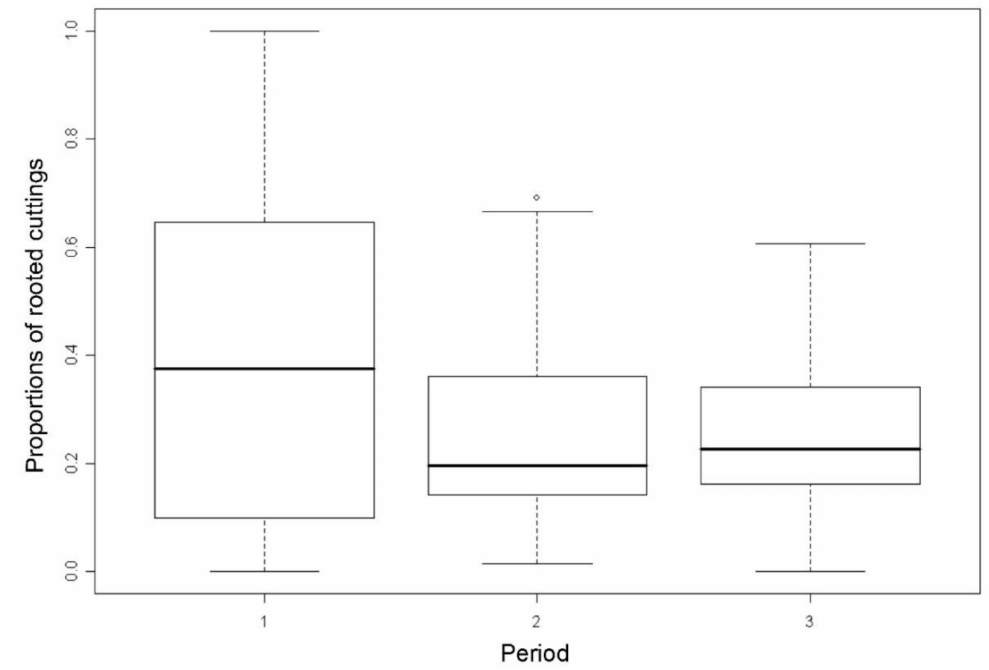
Figure 9. Box plot of proportions of rooted cuttings from the survived cuttings in relation to the cutting collection date. The horizontal line in each box represents the median, the hinges represent the 25th and 75th percentiles, the whiskers represent 1.5 times the interquartile range and open circles represent values outside this